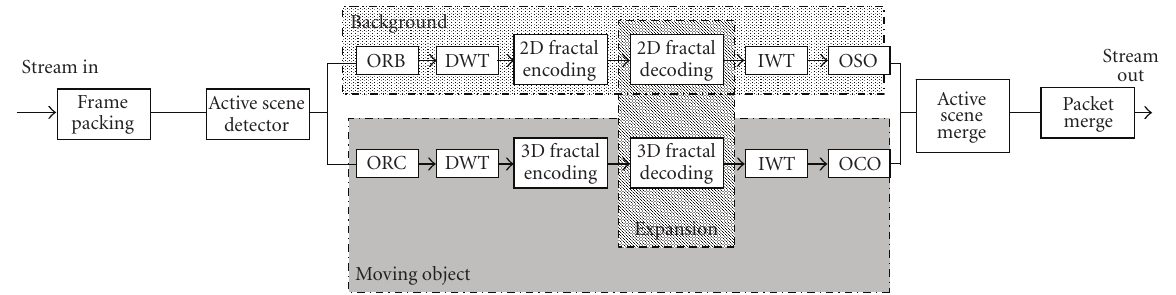
Figure 3: Flowchart of the proposed method.